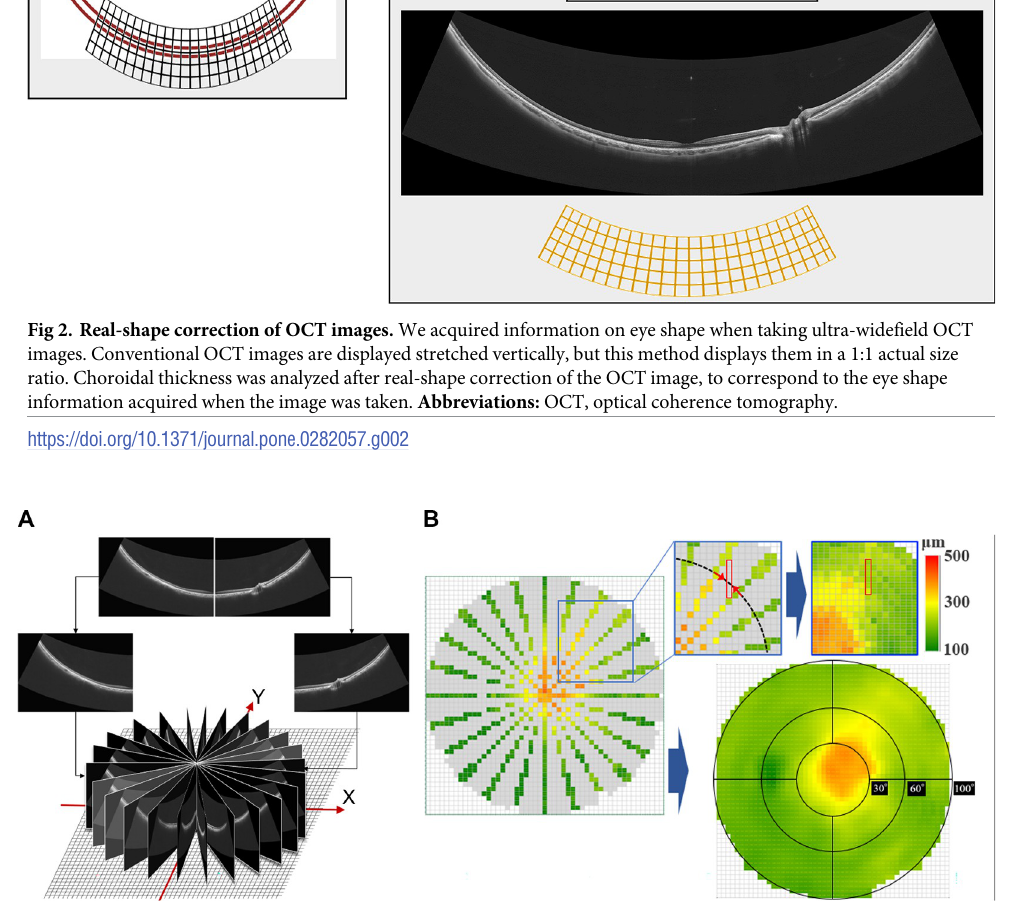
Fig 3. Dividing OCT B scans into sectors. We divided each OCT B image (obtained by 12 radial UWF-OCT scans) into two parts (at the center of the picture). (A) We measured the choroidal thickness at the boundary of the area, divided into 24 parts radially and evenly from the origin on the XY plane. (B) The area between the scans was linearly imputed based on the choroidal thickness measured from two scans in the vicinity of the concentric circles. The distance from the scan lines was measured to create a circular choroidal thickness map, with a diameter of 23 mm. This map was divided into a central area, (between the fovea and 30˚ from the fovea), a middle area (between 30˚ and 60˚ from the fovea), and a peripheral area (between 60˚ and 100˚ from the fovea). The middle and peripheral areas were divided into four quadrants: Supratemporal, infratemporal, supranasal, and infranasal. Abbreviations: OCT, optical coherence tomography; UWF-OCT, ultra-widefield